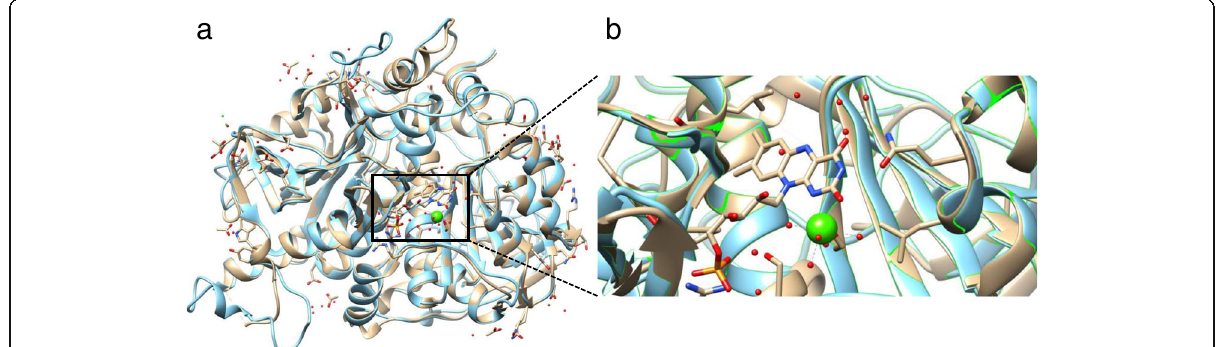
Fig. 1 a Matched crystal structures of putative nitroreductase from Arabidopsis thaliana (blue) and Anabaena variabilis (PDB 3EO7) (pale pink). b Closer look at the FMN (in the centre) binding site and Ca 2+ ion (green ball)